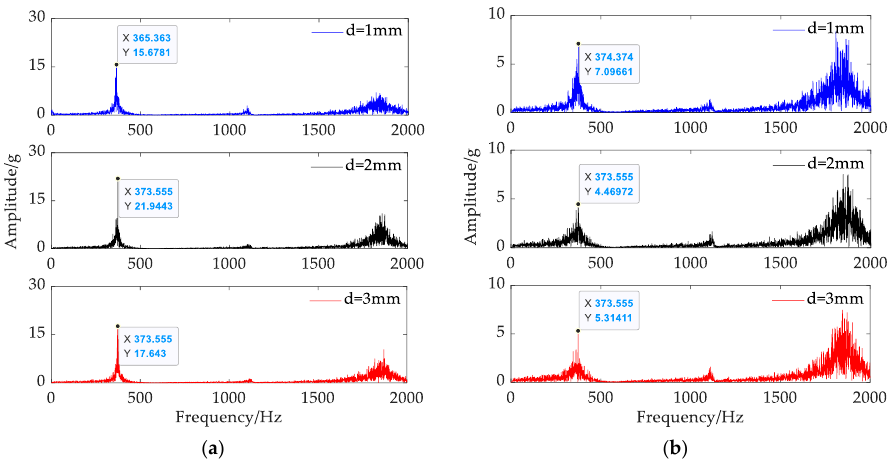
Figure 13. Comparison of frequency response with three particle sizes at the ( a ) 20%, ( b ) 80% filling rate.